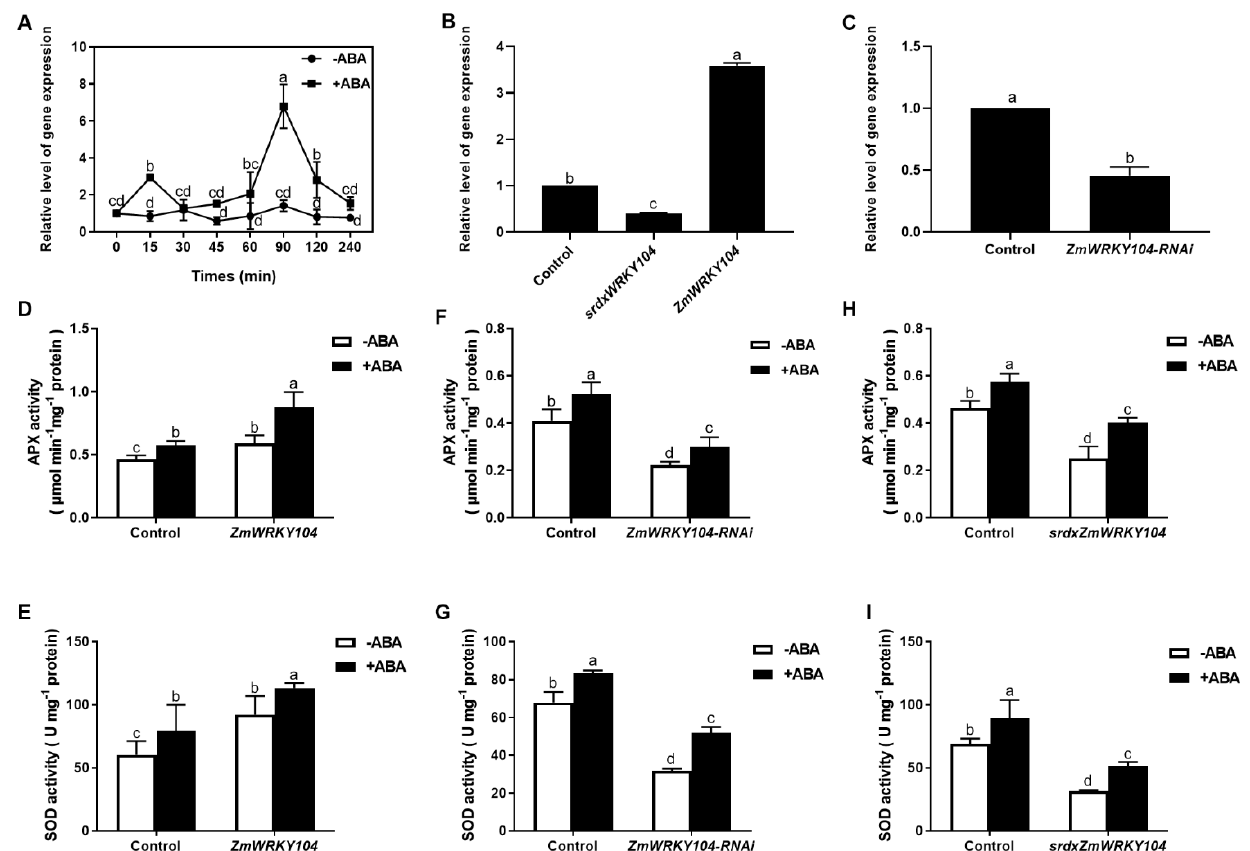
Figure 1. ZmWRKY104 is related to ABA−induced antioxidant defense. ( A ) Expression levels of ZmWRKY104 in maize leaves treated with ABA. The separated maize plants were treated with 100 µM ABA for different times. qRT−PCR detect the expression levels of ZmWRKY104 relative to ZmActin ; ( B ) detection of the efficiency of transiently overexpressing ZmWRKY104 and srdxZmWRKY104 in maize protoplasts; ( C ) detection of the efficiency of transiently silencing ZmWRKY104 in maize protoplasts. Gene expression analysis of ZmWRKY104 by RT−qPCR, with ZmActin as an internal control. Activities of APX ( D ) and SOD ( E ) of transiently expressing ZmWRKY104 in protoplasts. ZmWRKY104 (ubi: ZmWRKY104 −mCherry) or Control (empty vector) were transfected into protoplasts. Activities of APX ( F ) and SOD ( G ) of transiently silencing ZmWRKY104 in protoplasts. ZmWRKY104 −RNAi or Control (distilled water) were transfected into protoplasts. Activities of APX ( H ) and SOD ( I ) of transiently expressing srdxZmWRKY104 in protoplasts. srdxZmWRKY104 (ubi: ZmWRKY104 −SRDX−mCherry) or Control (empty vector) were transfected into protoplasts. Culture medium (−ABA) or 10 μM ABA (+ABA) were treated with the protoplasts for 10 min. Values are the means ± SE of three different experiments. According to Duncan’s multiple range test, means represented by the same letter did not significantly differ at p < 0.05.